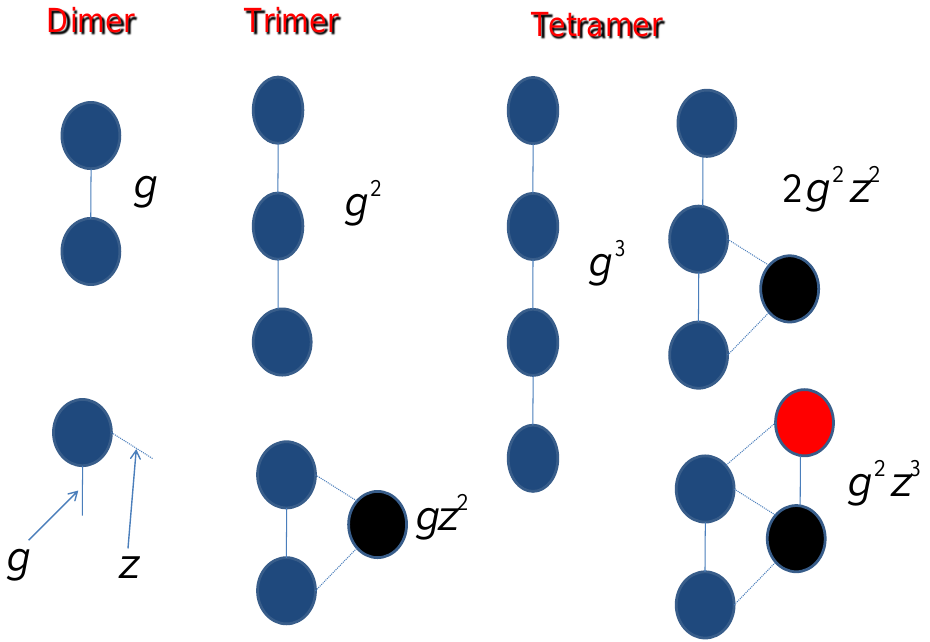
Figure 5. The assembly process is dependent on the molecular